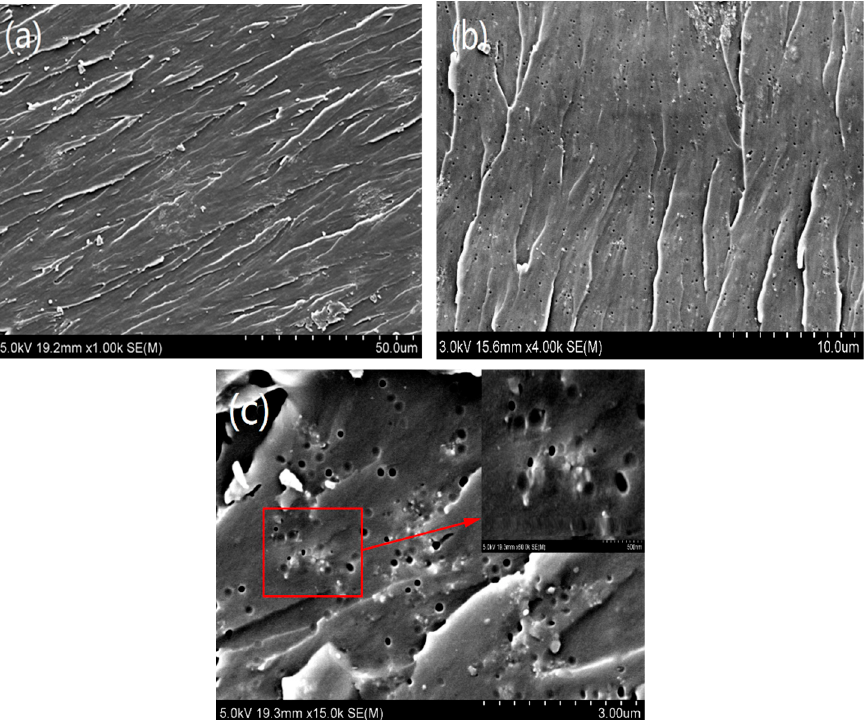
Figure 6. SEM analysis of a cross-section fracture of modified epoxy resin matrix: ( a ) × 1K; ( b ) × 4K; ( c ) × 15K.